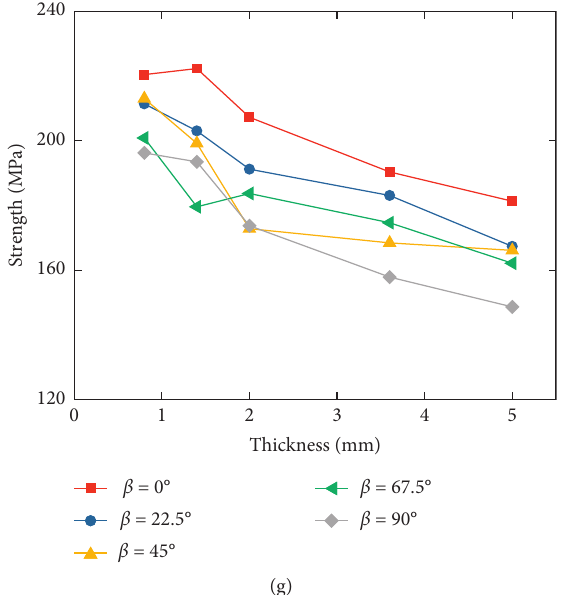
Figure 12: The cumulative distribution curve and average fragment size of layered rocks with different bedding thickness. (a–e) The distribution curve of 0 ° , 22.5 ° , 45 ° , 67.5 ° , and 90 ° samples, red: thickness � 0.8mm, blue: thickness � 1.4mm, yellow: thickness � 2.0mm, green: thickness � 3.6mm, and gray: thickness � 5.0mm. (f) Average fragment size vs. thickness under different bedding angles. (g) Dynamic strength vs. thickness under different bedding